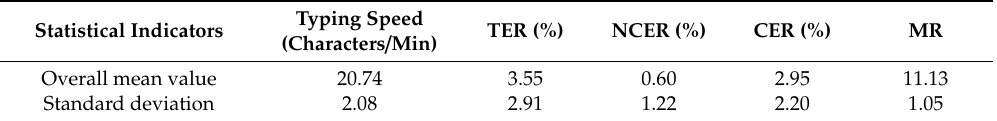
Table 5. Testing results obtained for the propose eye tracking interface used in eye typing application.